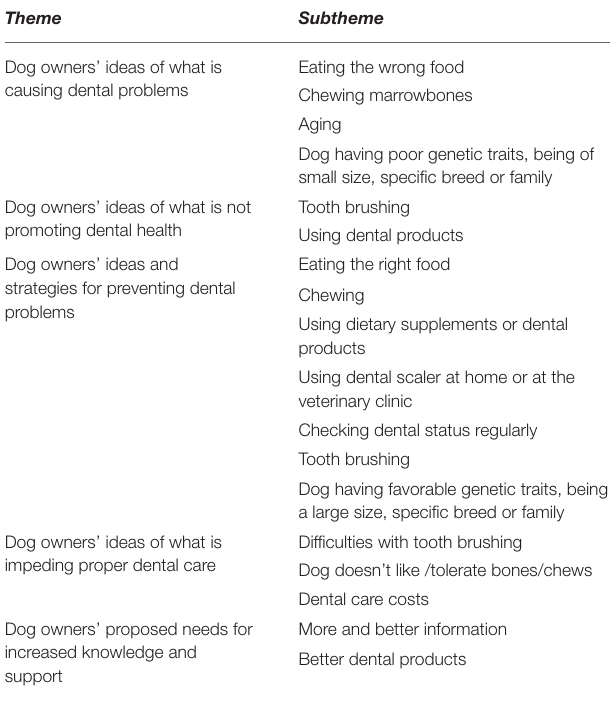
TABLE 1 | Themes and subthemes of the thematic